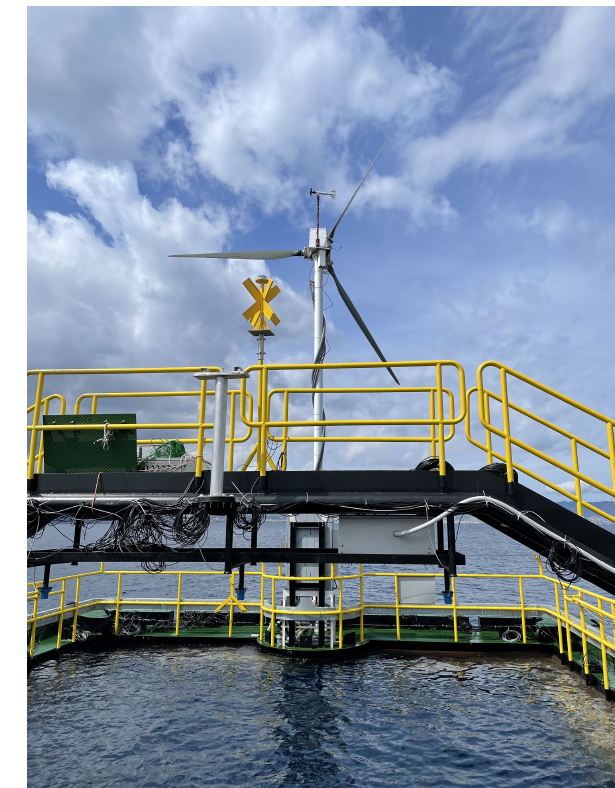
Figure 3. The large-scale wind turbine model.